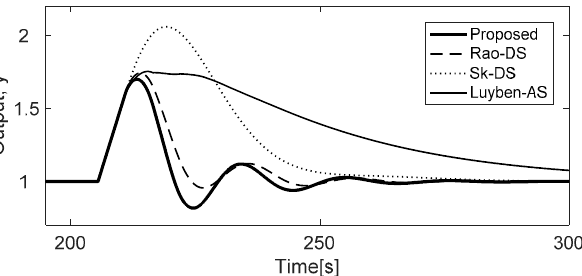
Figure 8. Regulatory responses to disturbance in PIPTD with +10% parameter mismatch.